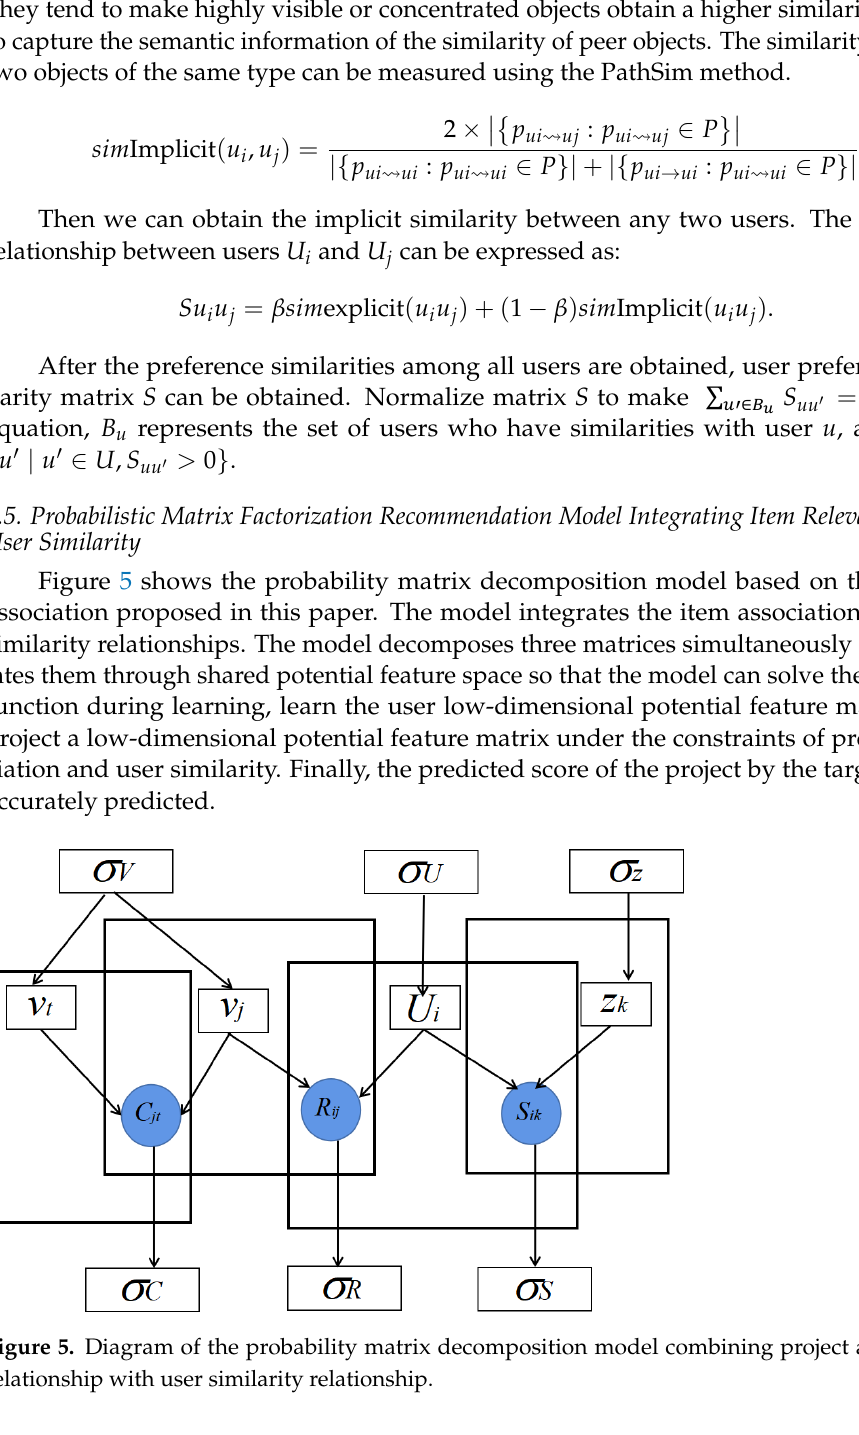
relationship with user similarity relationship.